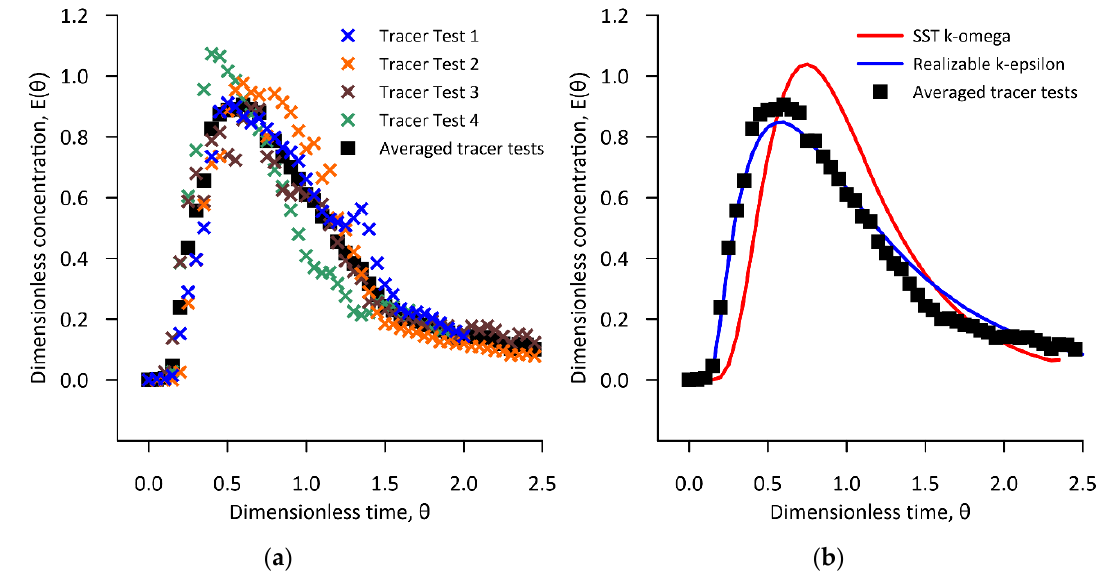
Figure 4. RTD curves: ( a ) RTD curves obtained from the tracer test in the laboratory-scale reactor, ( b ) comparison of simulated RTD curves with that obtained from the laboratory-scale reactor.